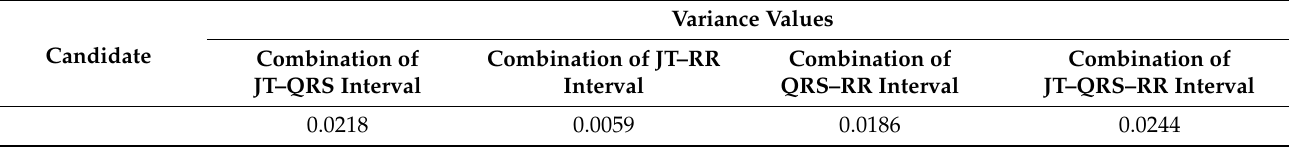
Table 2. The comparison between the sensitivity of 2-by-2 and 3-by-3 matrices. The variance value for each of the combination is tabulated for one of the candidates (see also Figure